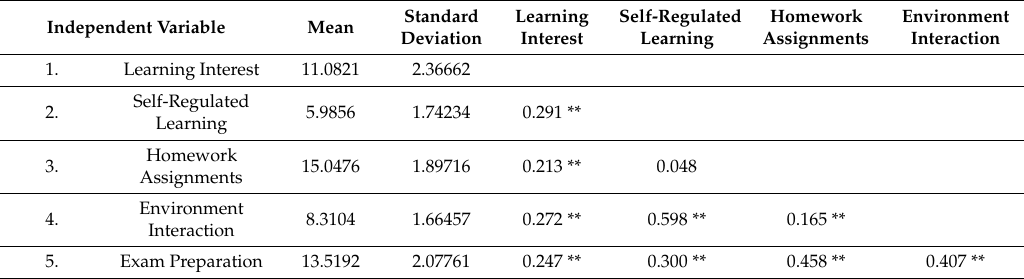
Table 2. Mean, standard deviations, and correlation coe ffi cients.